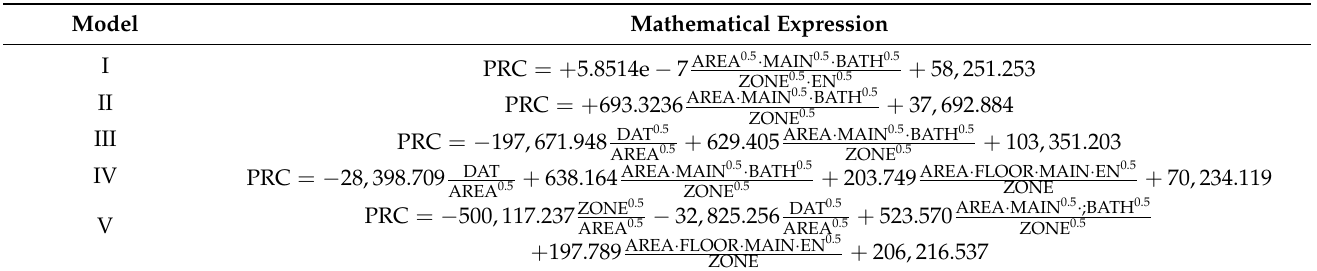
Table 3. Models generated by